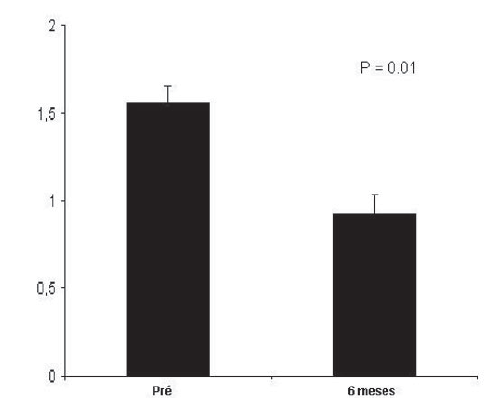
Fig. 3 - Escore isquêmico de VE determinado pela RMC pré e seis meses após o procedimento. Observamos redução significativa do índice isquêmico do ventrículo esquerdo, caindo de 1,64± 0,10 (pré-operatório) para 0,88± 0,09 (6 meses de pós-operatório), p=0,01